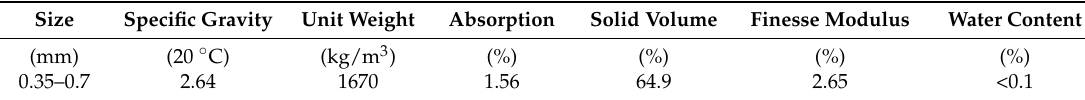
Table 4. Physical properties of the silica sand.